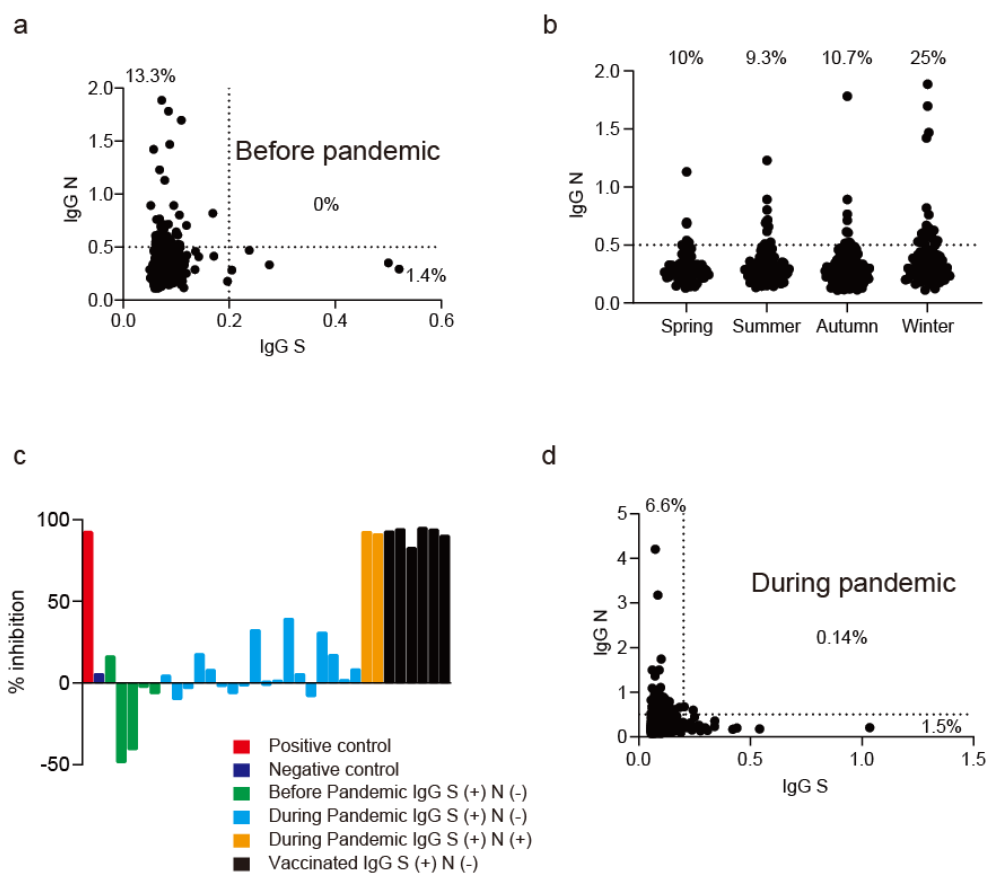
Figure 4. Humoral immunity to SARS-CoV-2 N and S proteins in sera obtained before and during pandemic. ( a ) IgG N and S titers of serum samples obtained before the COVID-19 pandemic ( n = 368). X and Y axes indicate the OD values at 450 nm absorbance evaluated by the Quo Research ELISA system. ( b ) IgG N titers of serum samples obtained before the COVID-19 pandemic according to season ( n = 368). Serum samples obtained from March to May, June to August, September to November, and December to February were regarded as samples obtained in spring, summer, autumn, and winter, respectively. ( c ) Neutralizing activity of serum samples regarded as IgG S (+) before and during the pandemic on S1 RBD and ACE2 binding. ( d ) IgG N and S titers of serum samples obtained during the COVID-19 pandemic ( n = 1423). X and Y axes indicate the OD values at 450 nm absorbance evaluated by the Quo Research ELISA system.